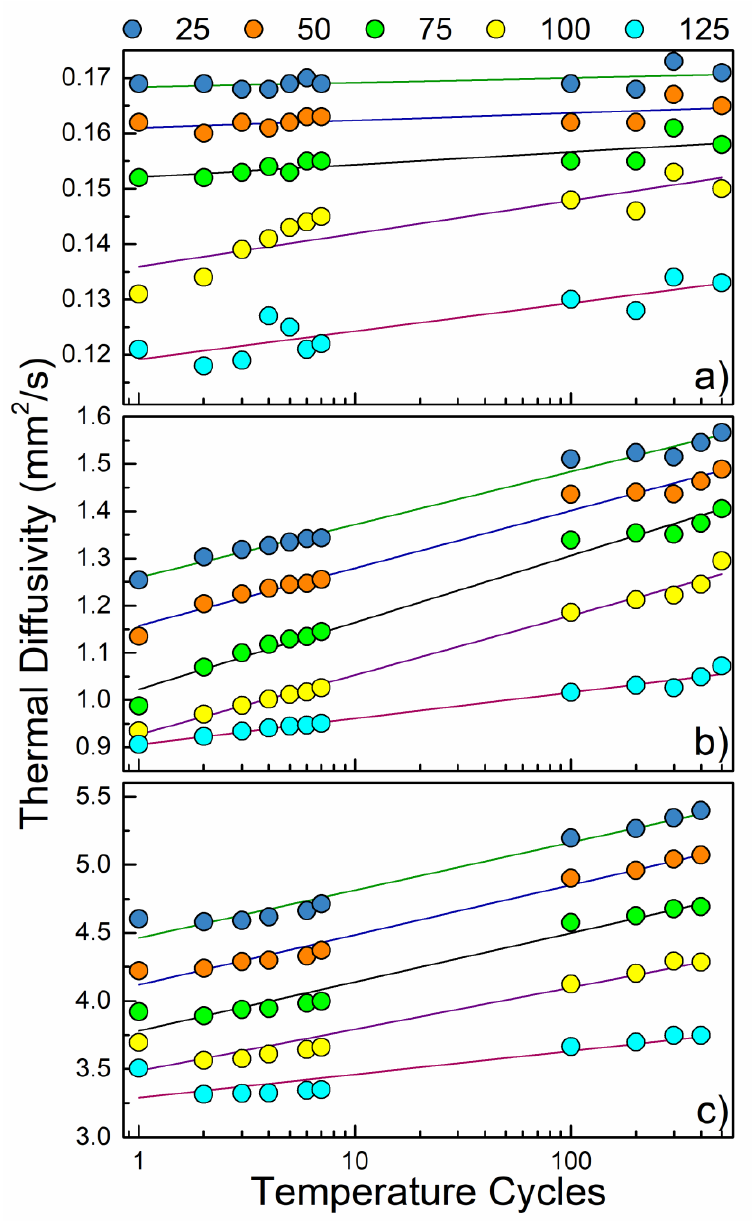
Figure 2. Thermal diffusivity for ( a ) pure epoxy matrix, ( b ) thermal interface materials (TIMs) with 5.4 vol% loading of graphene fillers, and ( c ) 30 vol% loading of graphene fillers. In each of the three samples, the measurements conducted at 25 °C resulted in the highest diffusivities. Additionally, increasing the number of heat treatment cycles either enhanced the thermal diffusivities or, in the case of the pure sample, had little to no effect depending on the temperature studied.